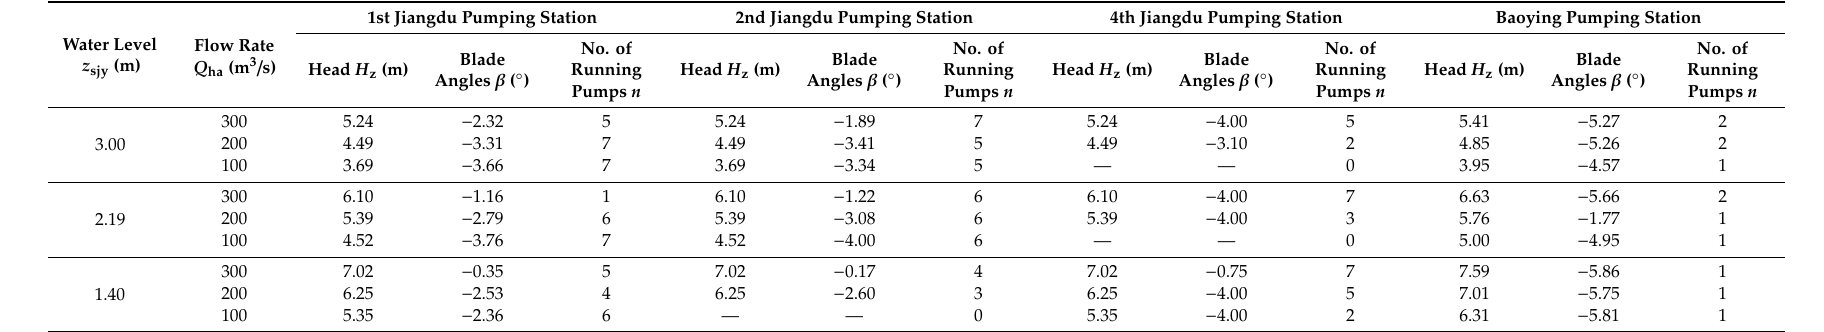
Table 6. Pump unit optimal operation schemes with optimal discharge